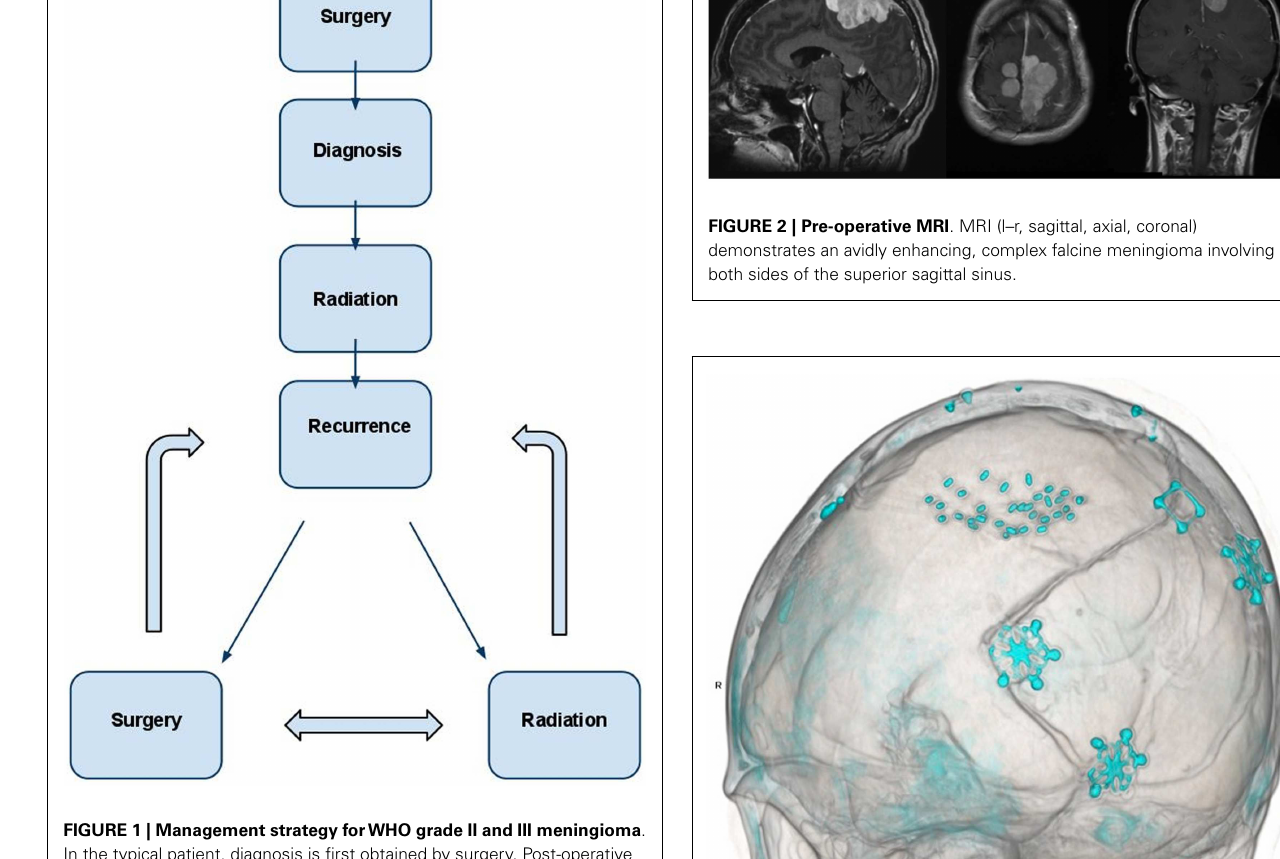
and non-irradiated patients did not reach statistical significance.